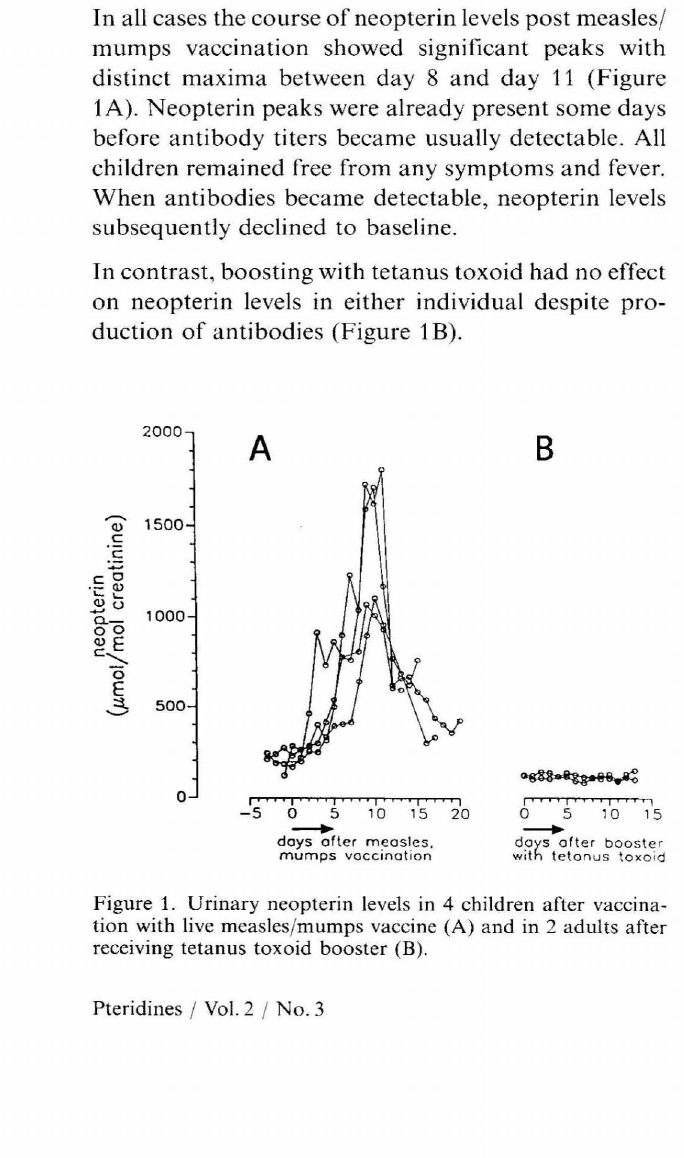
Figure 1. Urinary neopterin levels in 4 children after vaccina tion with live measles/mumps vaccine (A) and in 2 adu1ts after receiving tetanus toxoid booster (B). Pteridines / Vol. 2 /